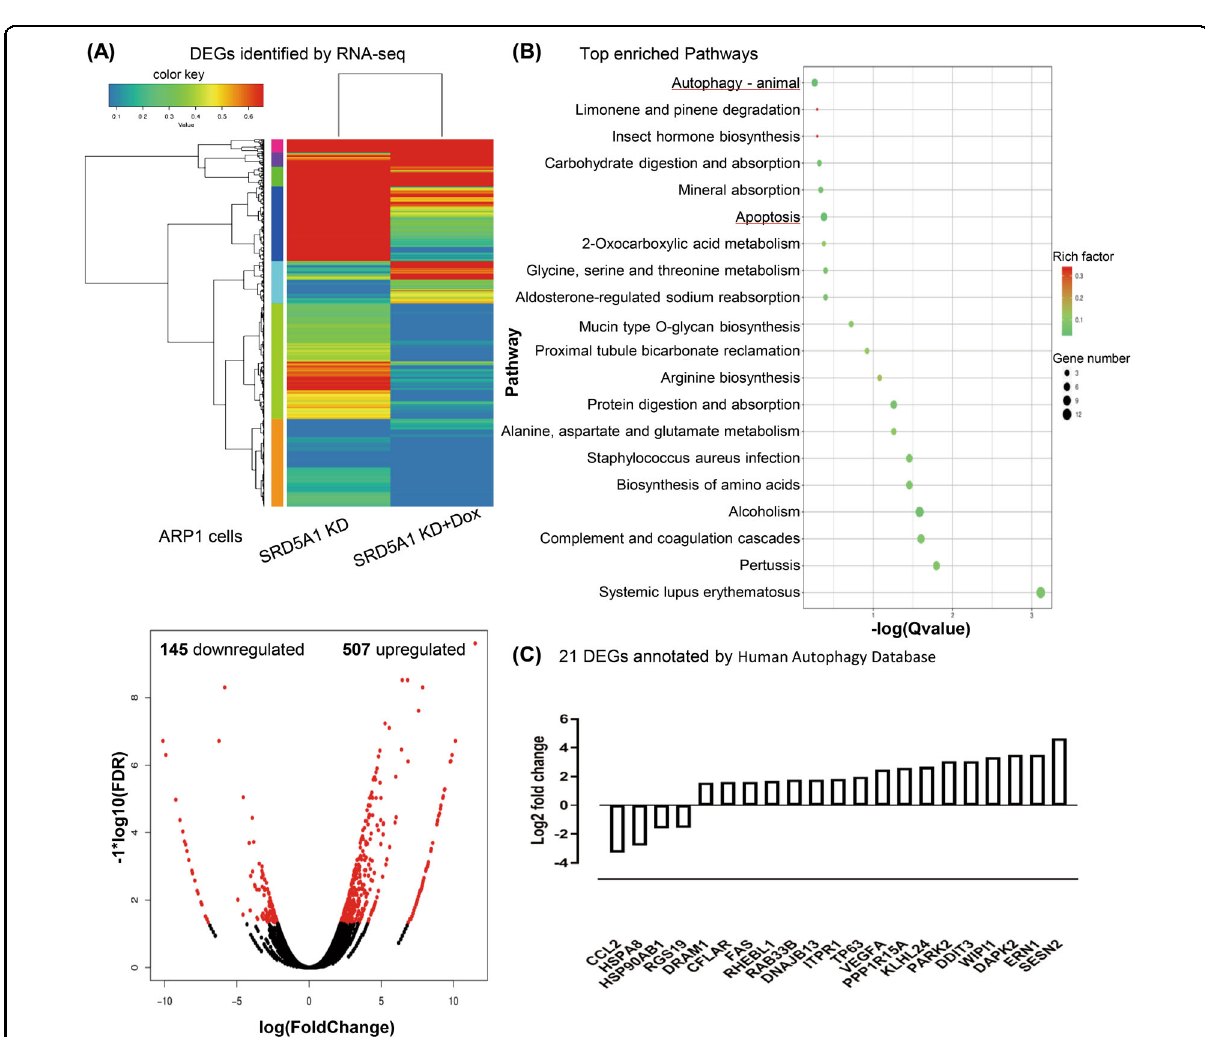
Fig. 4 RNA sequencing results reveal differentially expressed genes (DEGs) and enriched KEGG pathways in MM cells after downregulating SRD5A1. A Transcriptiomic RNA-seq identi fi ed 652 DEGs. Hierarchical cluster analysis (top) of signi fi cantly differentially expressed mRNAs between ARP1-SRD5A1-KD cells treated with and without Dox. Volcano plot (bottom) showing 145 decreased genes and 507 upregulated genes. B Top enriched KEGG pathways for these 652 DEGs, including autophagy and apoptosis signaling. C Twenty-one DEGs (including four downregulated